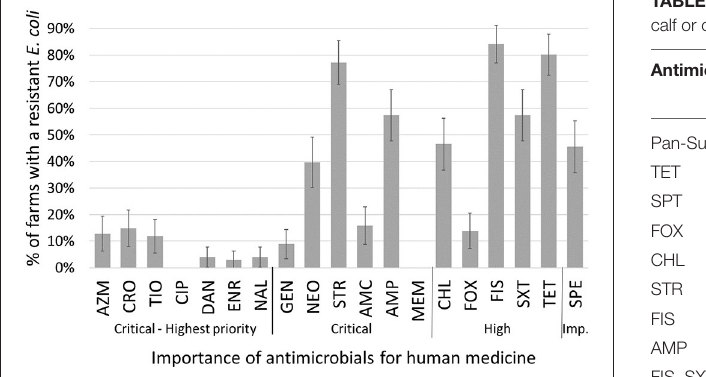
( Table 2 ). Twenty-two isolates were resistant to six or more antimicrobial classes and were observed in 19 different patterns ( Table 2 ). The resistance genes responsible for the highest levels of AMR toward tetracycline, sulfisozaxole, and streptomycin were, respectively : tet (A) , tet (B), sul 1 , sul 2 , sul 3 , aph( 3” )-Ib